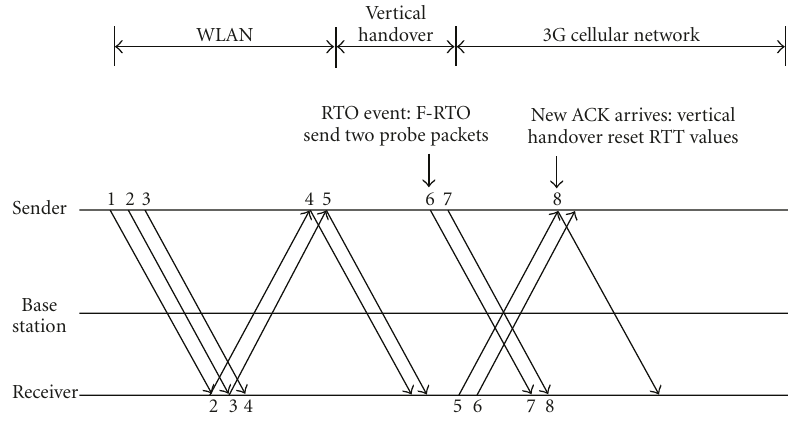
Figure 8: Behavior on vertical handover.